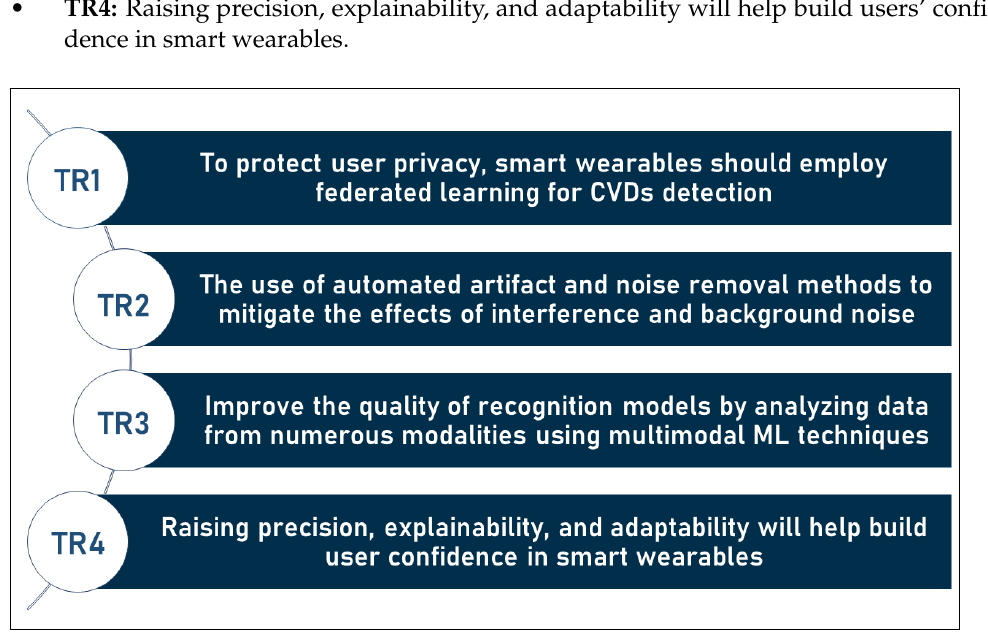
Figure 11. Research topics that may serve as solutions to the challenges in the domain.